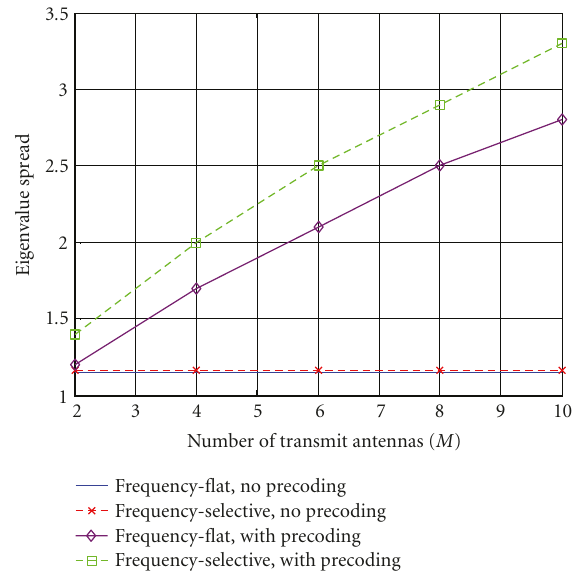
Figure 6: Eigenvalue spread before and after applying precoding.